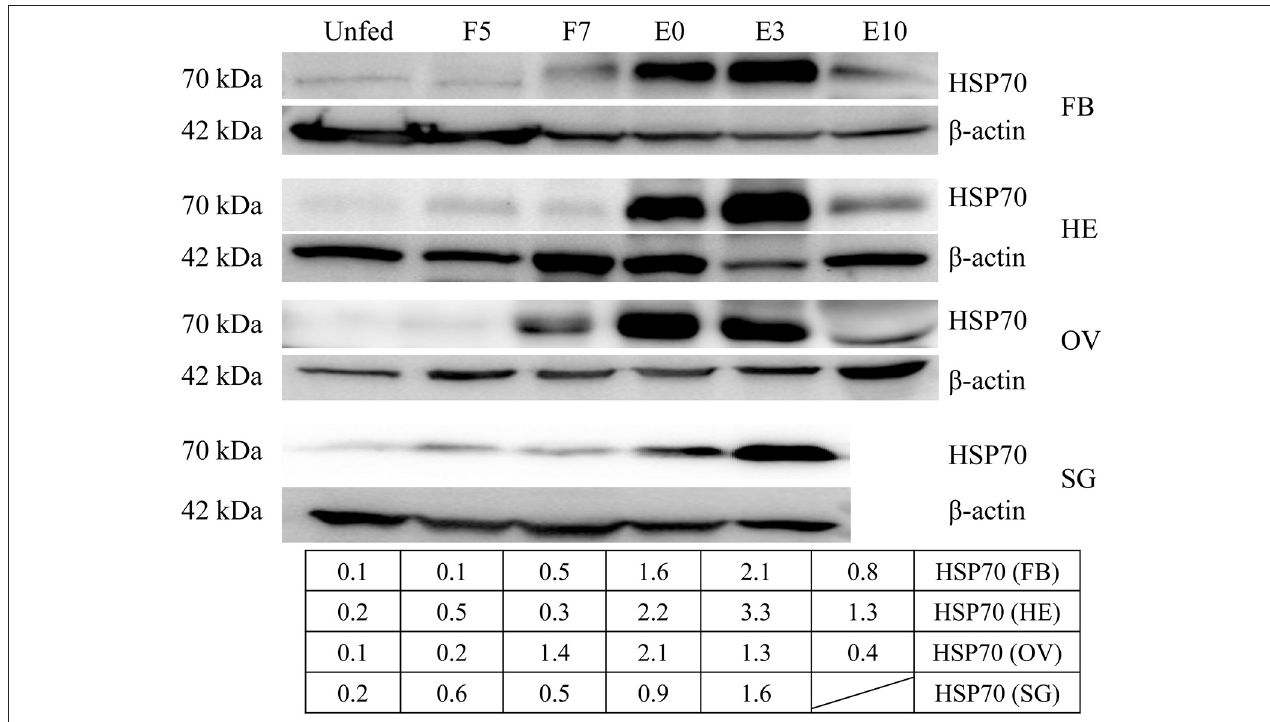
FIGURE 6 | HSP70 protein was widely distributed in a variety of organs and accelerated by blood feeding. HSP70 protein was expressed widely in fat body, hemolymph, ovary and salivary gland of adult ticks at 5 days blood feeding, 7 days blood feeding, engorgement, 3 days post-engorgement and 10 days post-engorgement by Western blot. The intensities of HSP70 protein were determined and normalized to β -actin. β -actin bands were used in the previous Figure 2 . FB, fat body; HE, hemolymph; OV, ovary; SG, salivary gland; UF, unfed; F5, at day 5 for blood feeding; F7, at day 7 for blood feeding; E0, on the day of engorgement; E3, at 3 days post-engorgement; E10, at day 10 after engorgement.